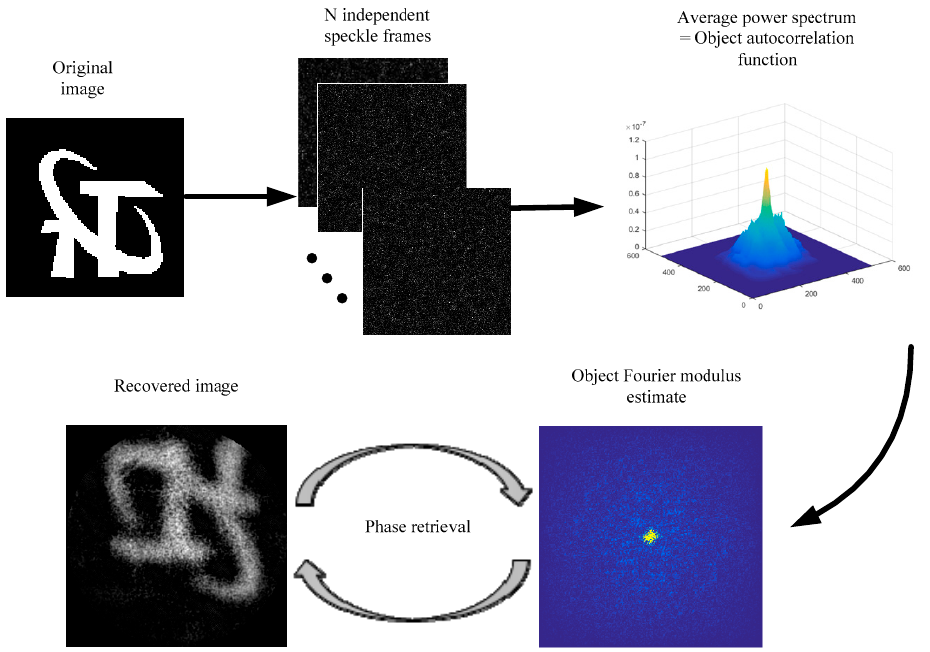
Figure 2. Block diagram of the imaging correlography.